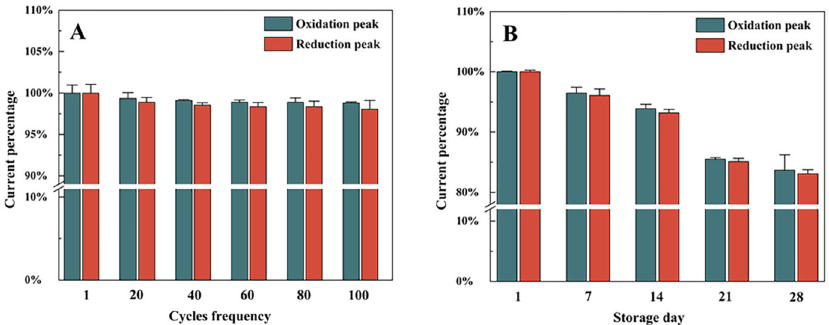
Figure 9. Peak current of the NF/GDH/IL/mPEG-fMWCNTs-modified GCE versus ( A ) cycle frequencies (1, 20, 40, 60, 80, and 100 cycles). ( B ) Storage stability (1, 7, 14, 21, and 28 days). The experiments were conducted in PBS (50 mM, pH 7.0) versus Ag/AgCl. at scan rate of 0.05 V s − 1 , 25 ± 1 °C.